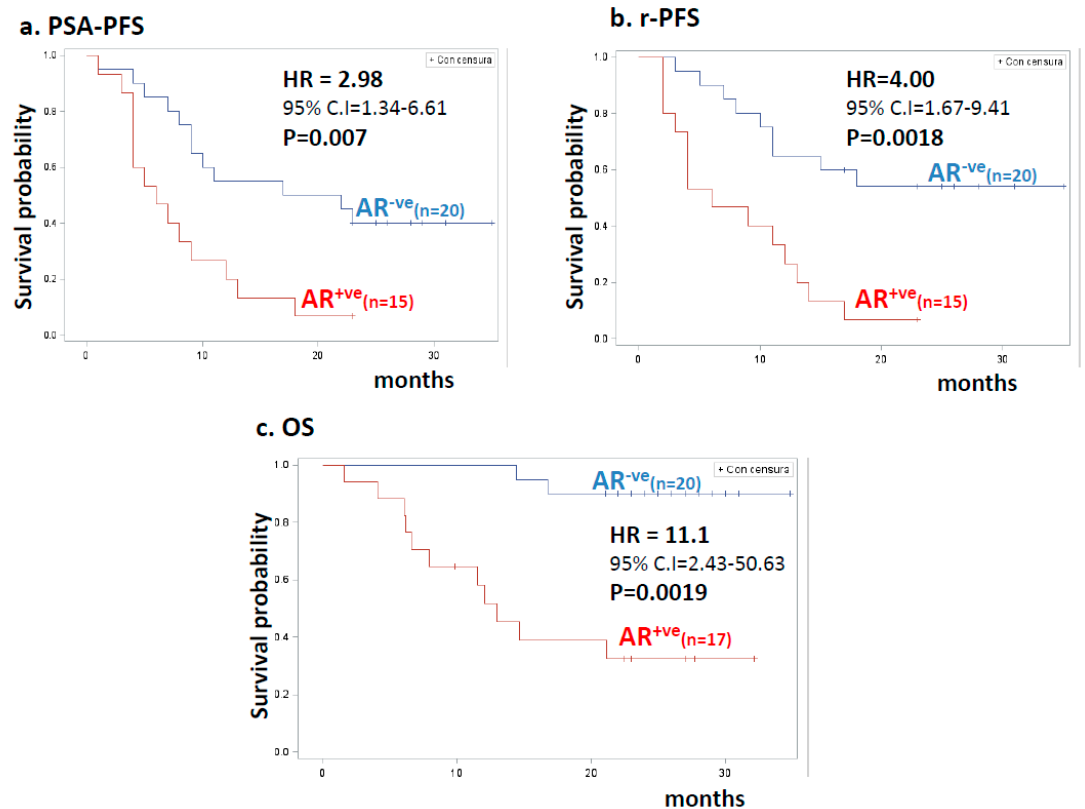
Figure 2. Kaplan–Meier estimates for clinical outcome in patients stratified by AR detection.